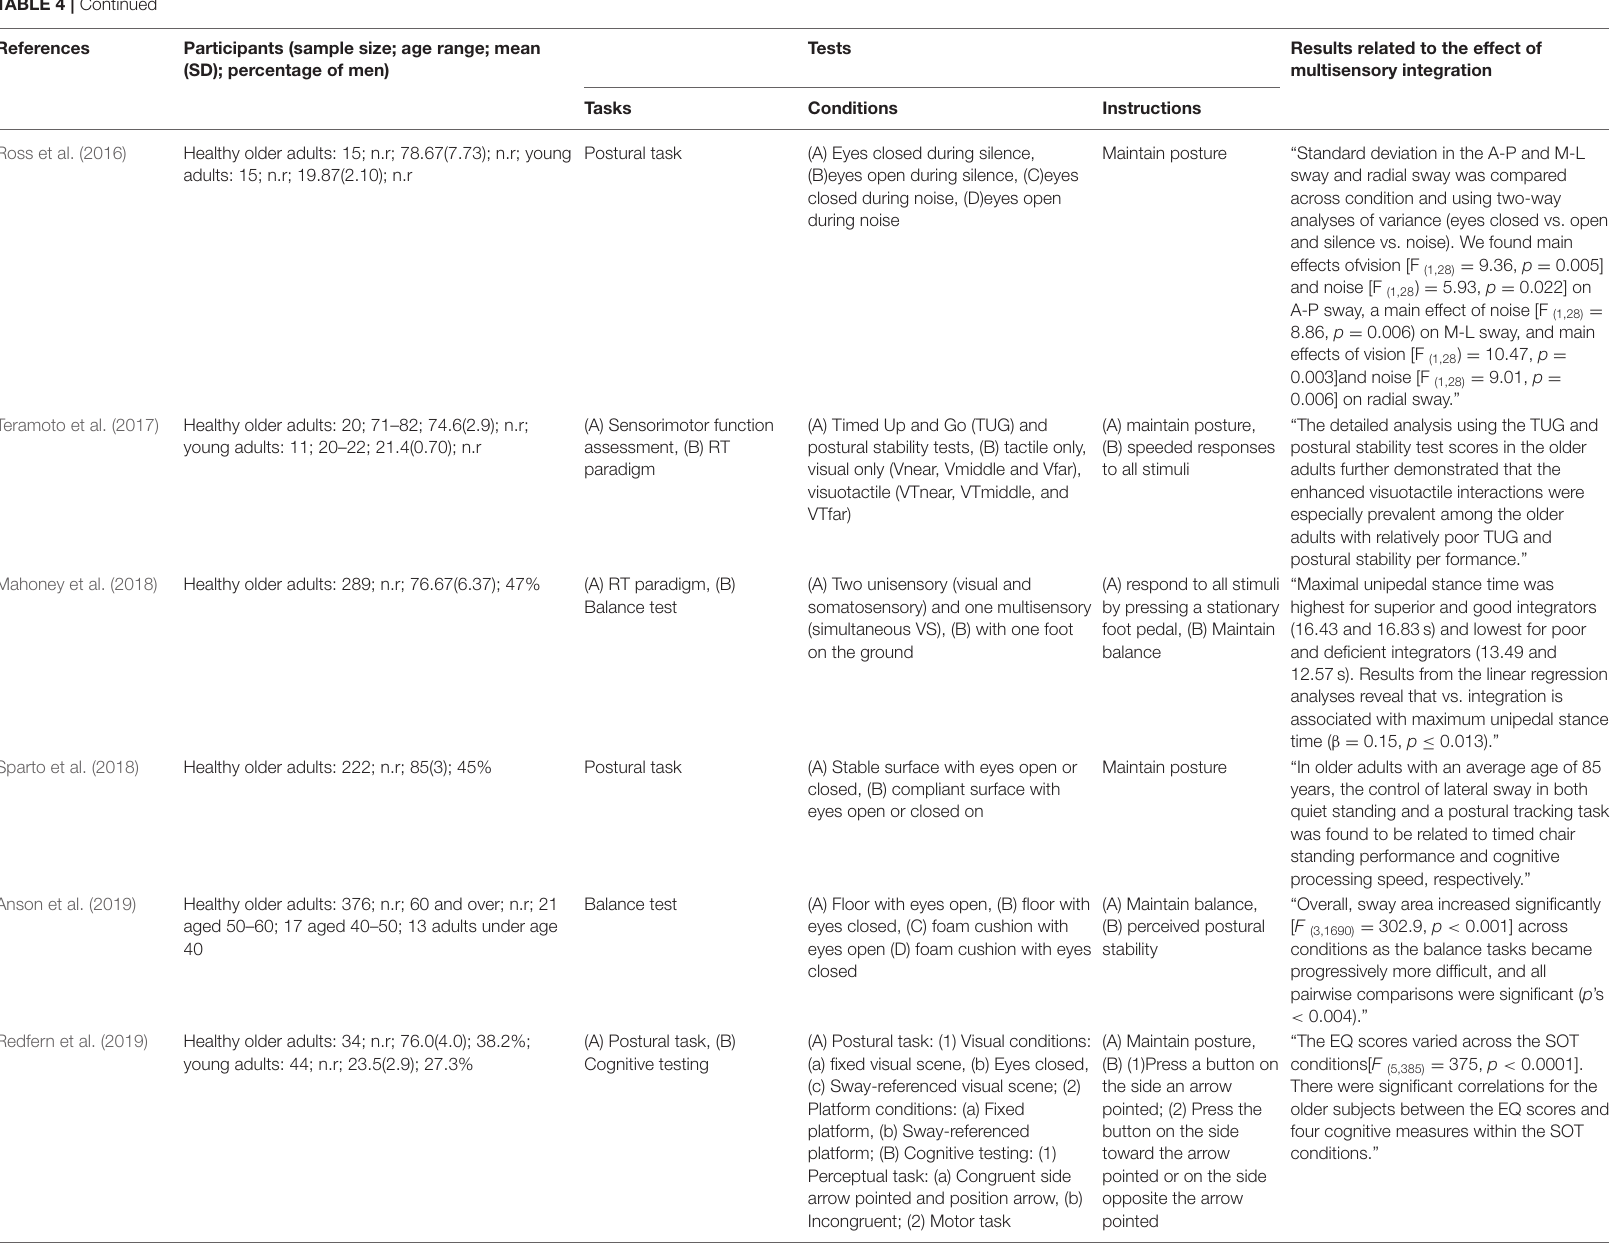
paradigm visual only (Vnear, Vmiddle and Vfar), visuotactile (VTnear, VTmiddle, and (A) Floor with eyes open, (B) floor with eyes closed, (C) foam cushion with eyes open (D) foam cushion with eyes closed